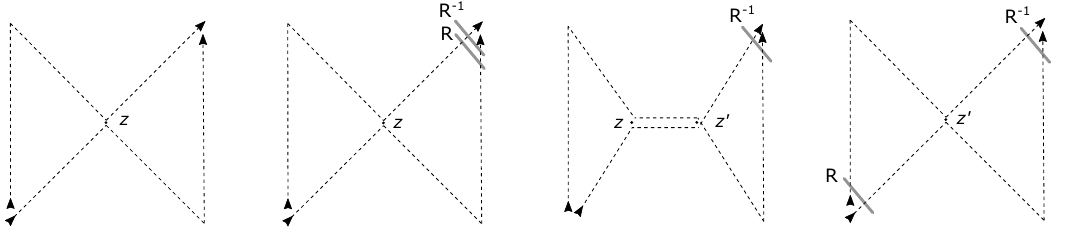
( b − b 0 ) R ( b 0 − b ) (2); ‘,‘ 0 ‘,‘ 0